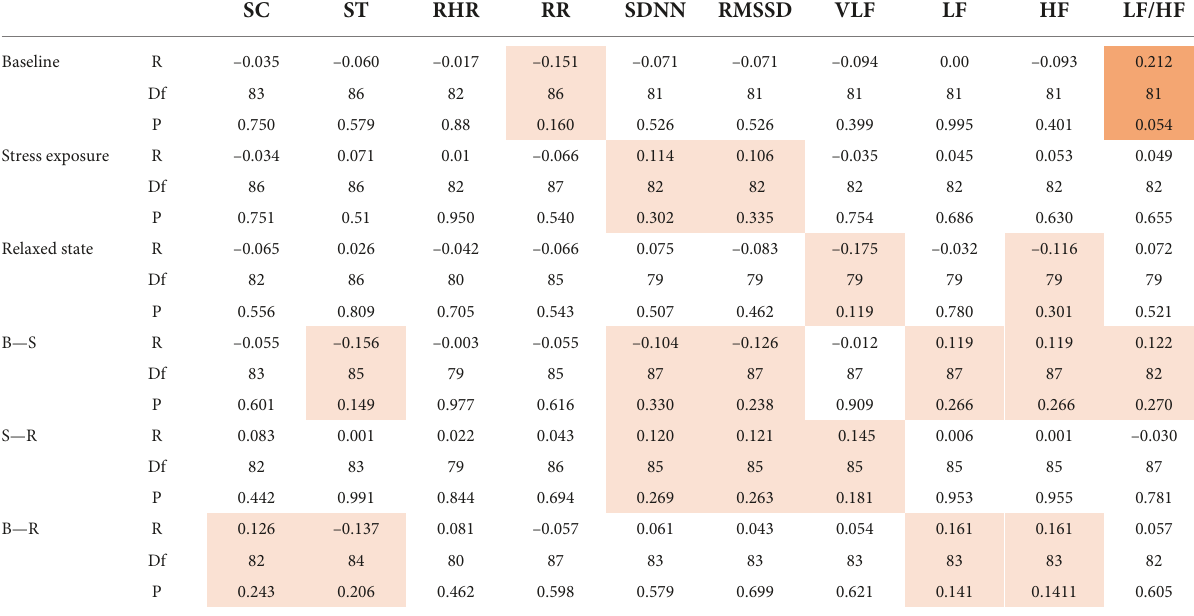
TABLE 2 Correlation of FMI and electrophysiological parameters across the three different